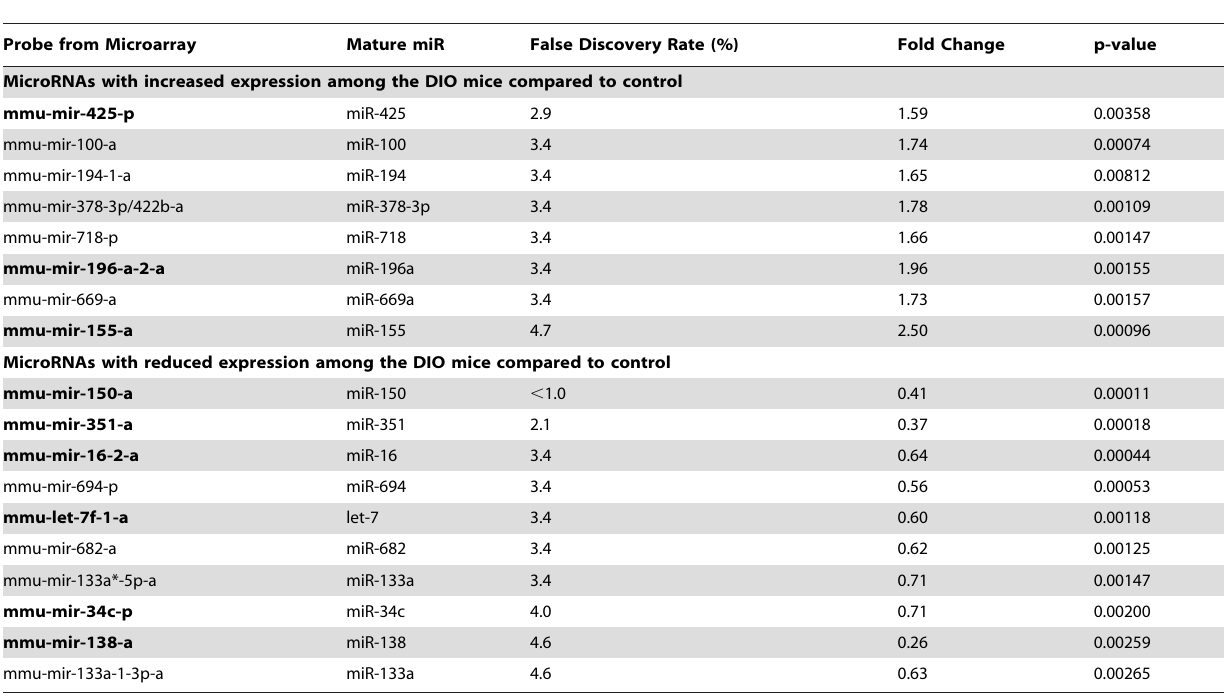
Table 2. Obesity is associated with differences in microRNA